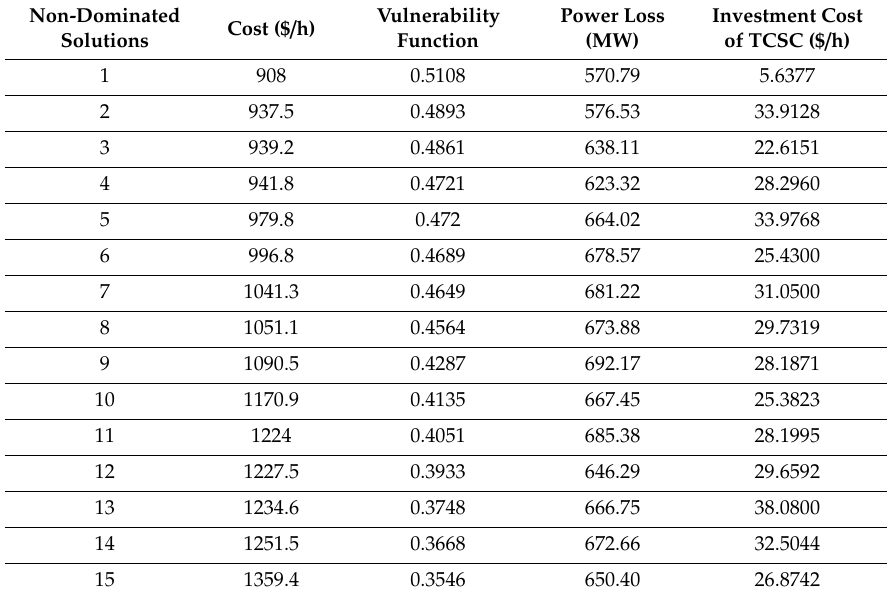
Table 4. Detailed Information about the Obtained Pareto-Front in the Case of Considering Loss Constraint Shown in Figure